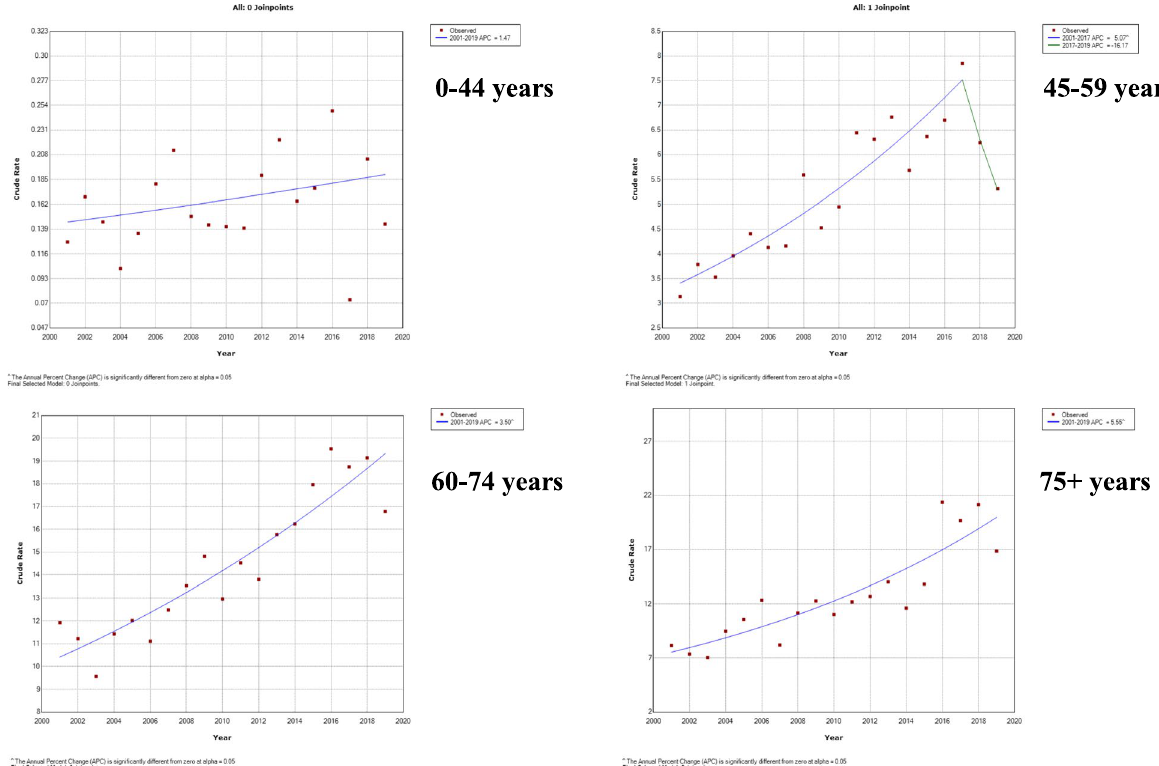
Fig. 3 Joinpoint regression analysis of age-categorised trends in the incidence of laryngeal cancer including all patients from 2001 to 2019 in Sri